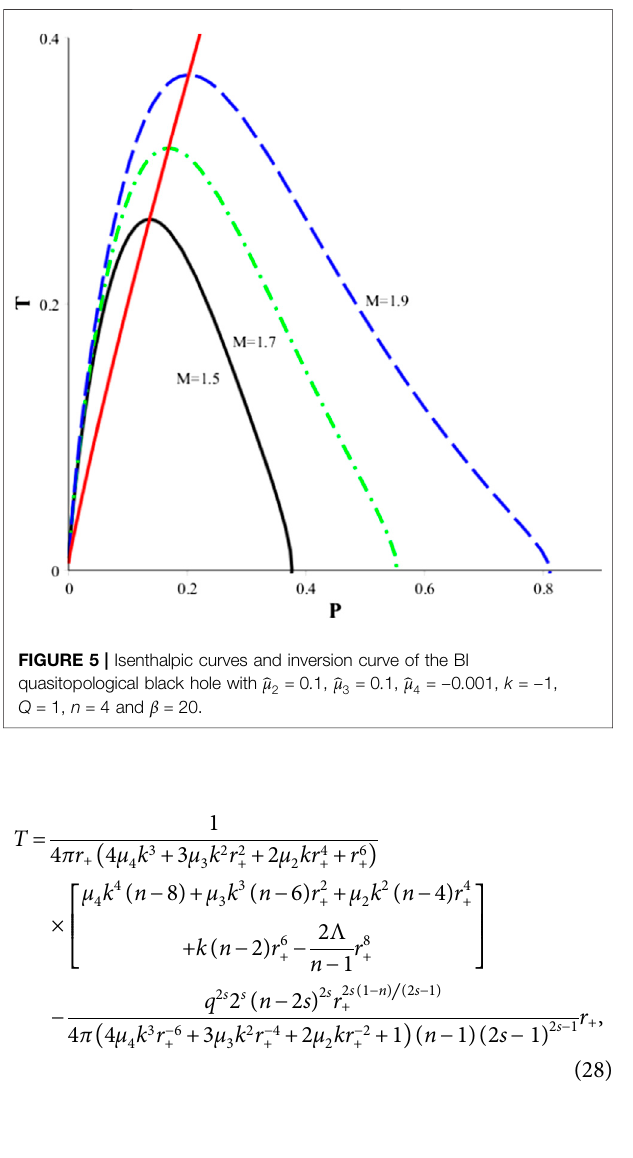
Frontiers in Physics |